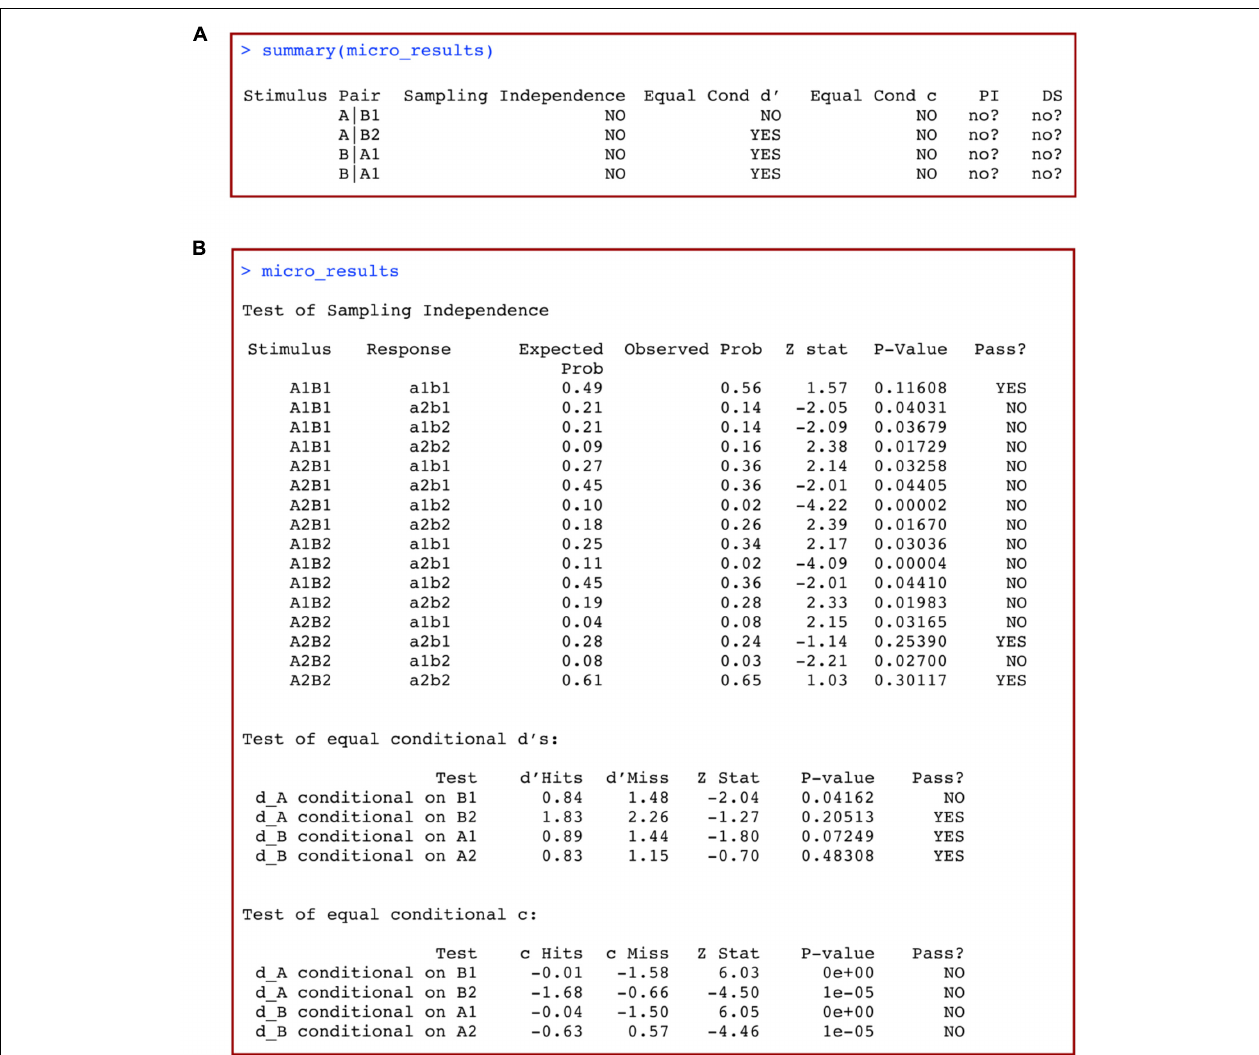
FIGURE 5 | (A) Summary and (B) full results of a macro-analysis of data from a 2 × 2 identification design with grtools